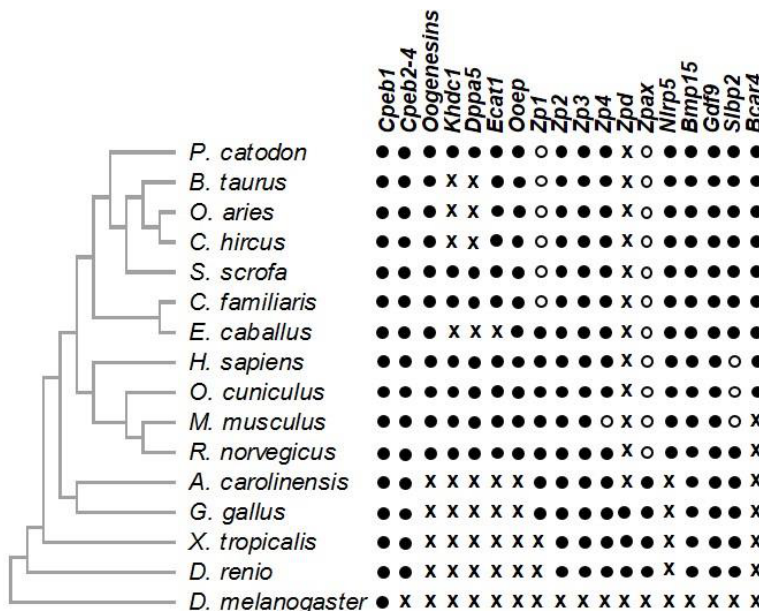
maturation and after fertilization, as suggested in Xenopus [26].